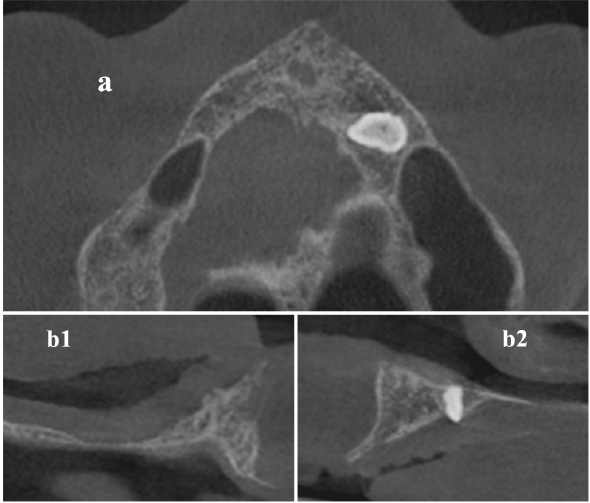
Figure 1. Cone-Beam-Computed-Tomography (CBCT) axial ( a ) and cross-sectional ( b1,b2 ) images before surgical procedure.